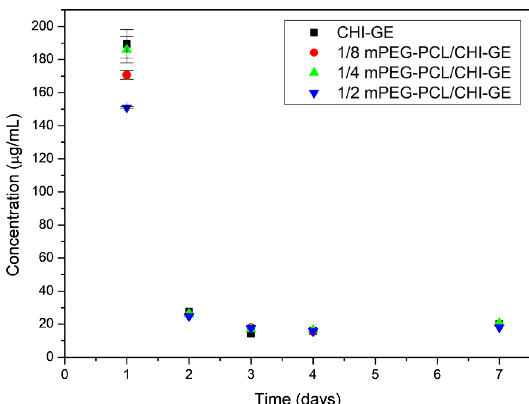
Figure 7. Long-term in vitro gentamicin release from (black) CHI-GE, (red) 1/8 mPEG-PCL/CHI, (green) 1/4 mPEG-PCL/CHI and (blue) 1/2 mPEG-PCL/CHI at every 24 hours for one week.